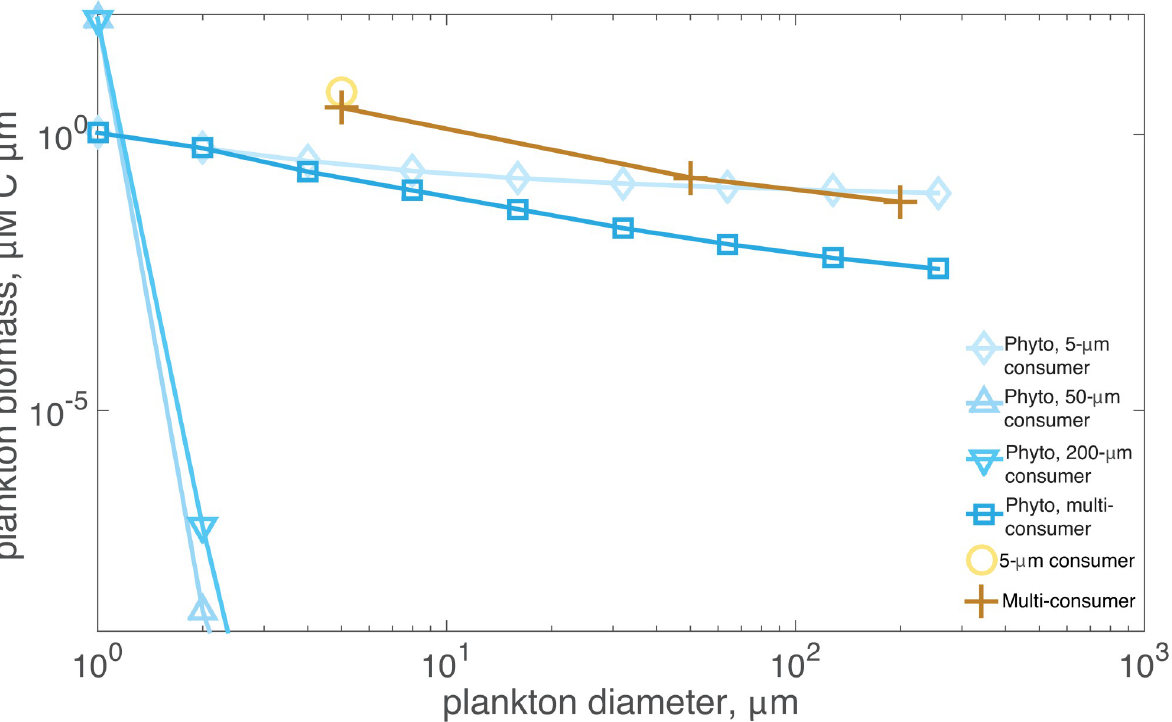
Fig 1. Planktonic biomass for nutrient-phytoplankton-zooplankton model systems with grazers of different sizes. The model systems include grazers of either 5, 50, or 200 μ m diameter, and the multi-consumer model system corresponds to a system with all three sized consumers. The blue symbols correspond to the phytoplankton biomass for each of those systems (diamond for the 5- μ m consumer system, upward triangle for 50- μ m consumer, downward triangle for 200- μ m consumer, and square for multi-consumer system). The yellow symbols correspond to consumer normalized biomass values (circle for the 5- μ m consumer, and plus sign for the multi-consumer system). The 50- and 200- μ m grazers did not survive in single consumer size class simulations and thus no results are